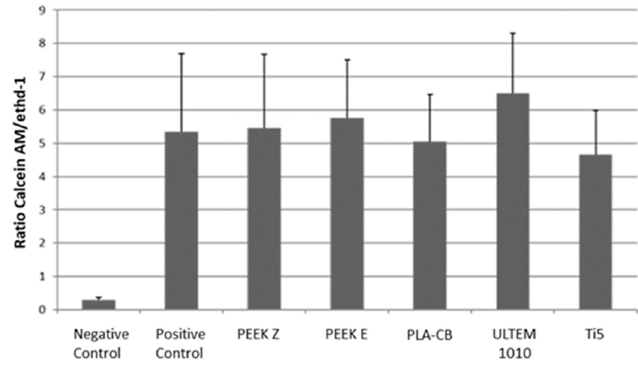
Figure 9. Ratio of live/dead cells of the biomaterials after 7 days.